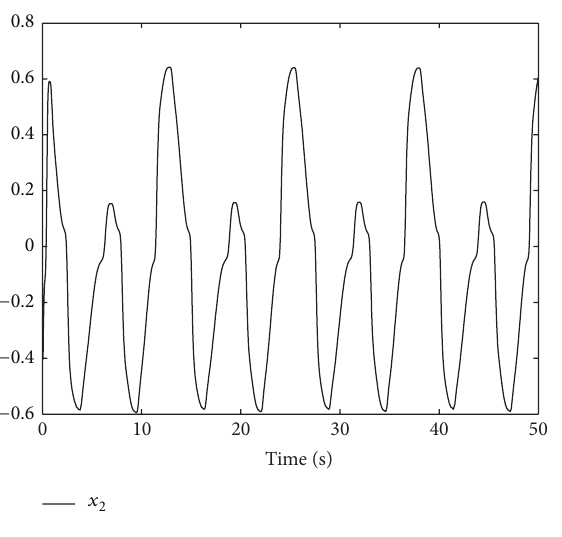
Figure 4: The true control input 𝑢